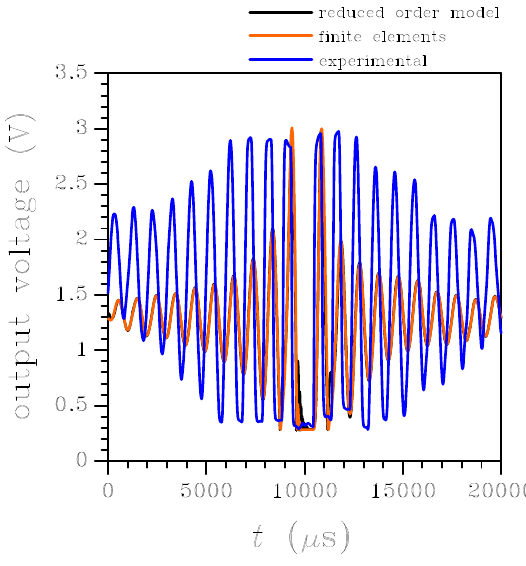
Figure 6. Low- g test: time evolution of MEMS output. Comparison between experimental data and numerical results.